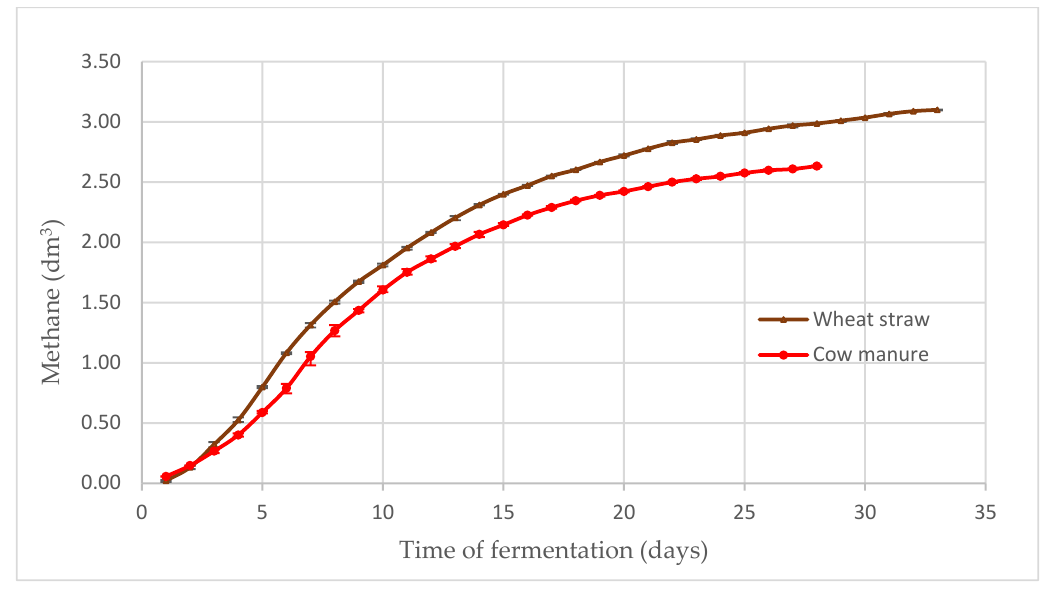
Figure 5. Methane production during the samples’ fermentation process (daily measurements) for both materials, with error bars (the initial sample masses were different).